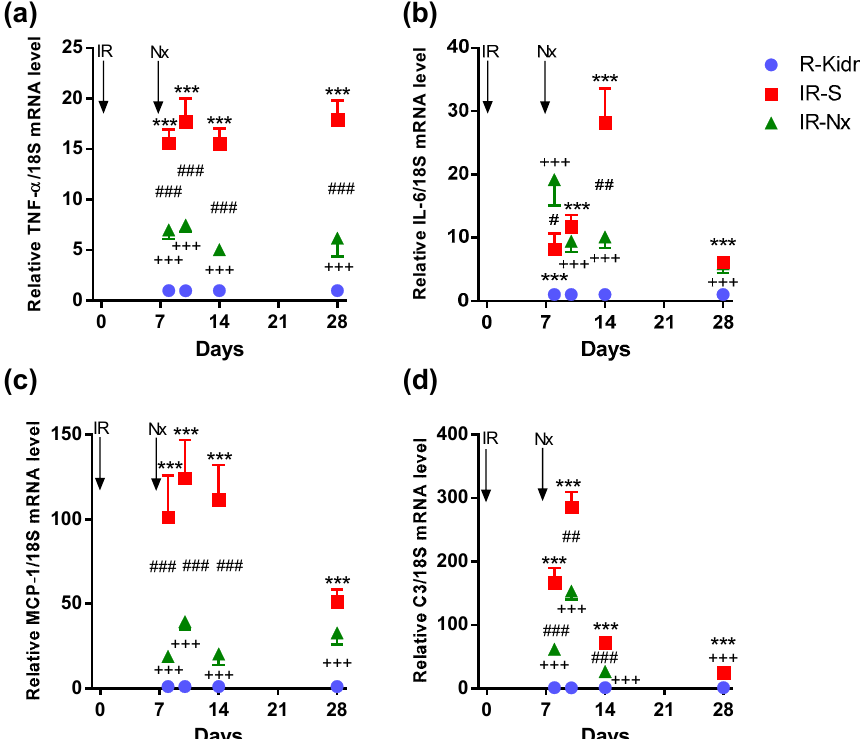
Figure 6. Fold changes in inflammation- and immune system-related mRNAs normalized to 18S. ( a ) TNF- α , ( b ) IL-6, ( c ) MCP-1 and ( d ) C3. Data are expressed as mean ± SEM; two-way ANOVA with Tukey’s post hoc test. ***: p < 0.001 IR-S (red) vs. nonischemic right kidneys (blue); +++: p < 0.001 IR-Nx (green) vs. nonischemic right kidneys (blue), #: p < 0.05, ##: p < 0.01 and ###: p < 0.001 IR-S (red) vs. IR-Nx (green).